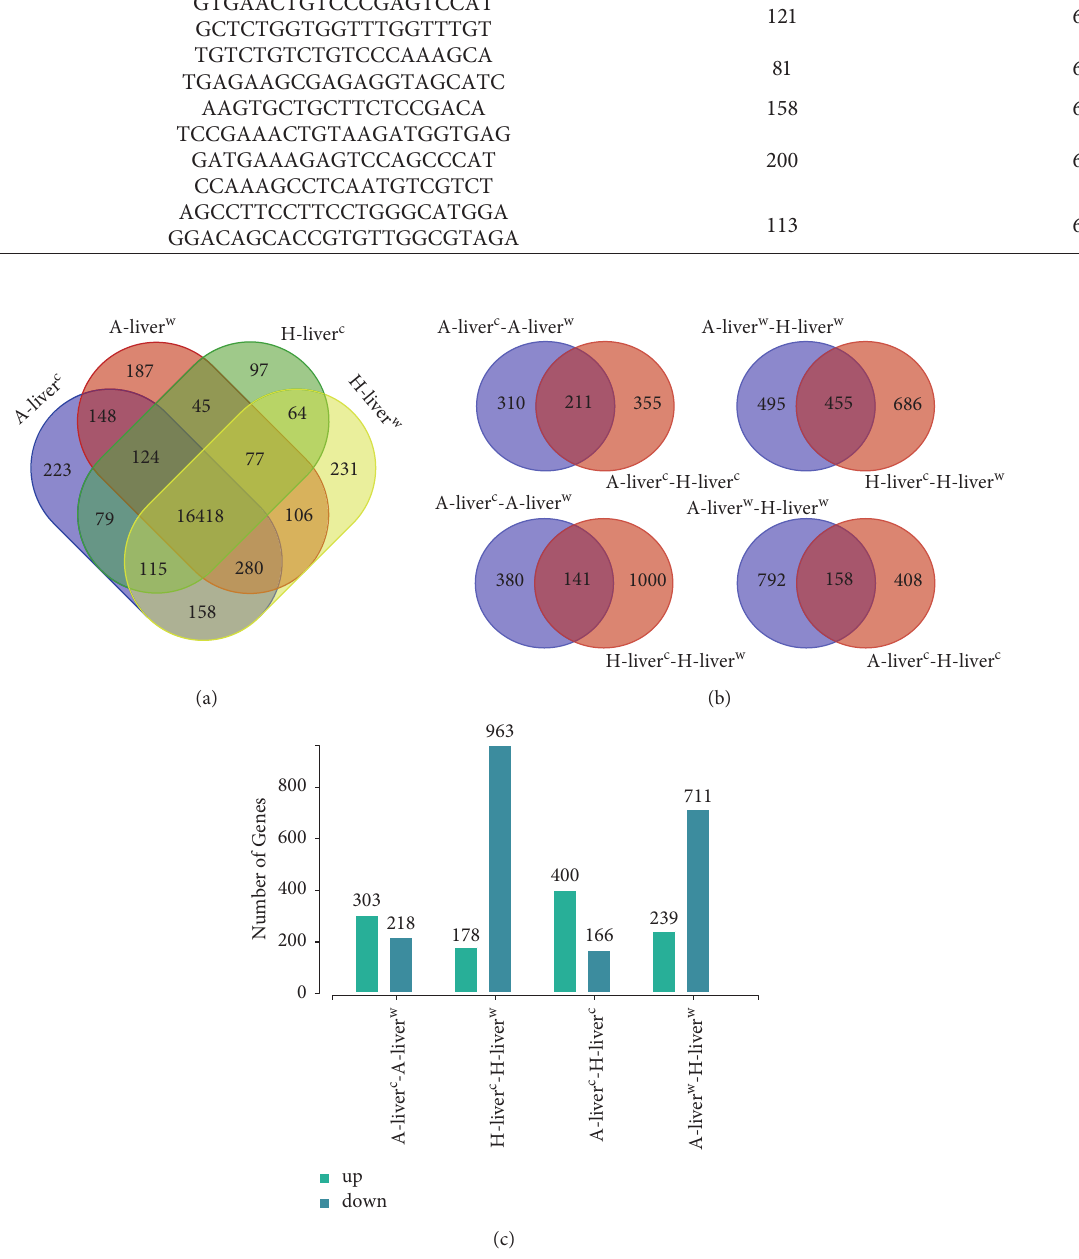
Figure 1: DEGs in the liver of cold-exposed Altay and Hu lambs. A-liver c -A-liver w : liver of − 5 ° C Altay lambs ( n � 5) compared to 20 ° C Altay lambs ( n � 4); H-liver c -H-liver w : liver of − 5 ° C Hu lambs ( n � 6) compared to 20 ° C Hu lambs ( n � 4); A-liver c -H-liver c : liver of − 5 ° C Altay lambs ( n � 5) compared to − 5 ° C Hu lambs ( n � 6); A-liver w -H-liver w : liver of 20 ° C Altay lambs ( n � 4) compared to 20 ° C Hu lambs ( n � 4). (a) DEGs among different treatment groups. (b) DEGs between differently compared groups. (c) The up- and downregulated DEGs between differently compared groups. The screen of DEGs is based on |log2 FC| > 1 and q value < 0.05. The green columns represent upregulated DEGs, and blue columns represent downregulated